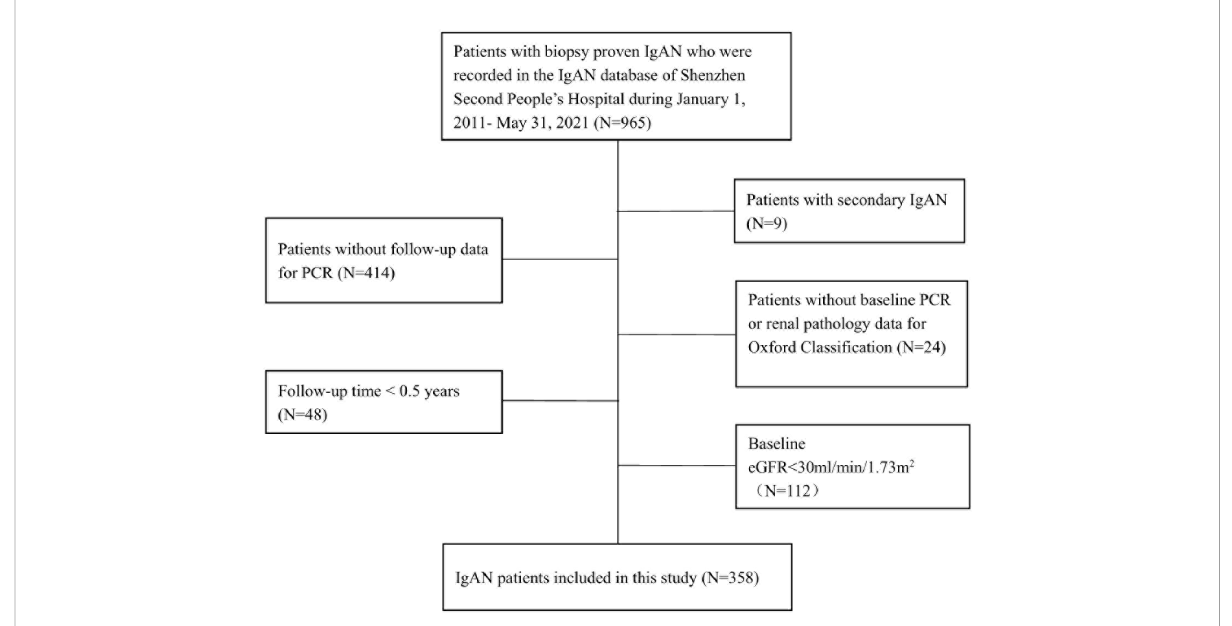
FIGURE 1 Flowchart of patients with immunoglobulin A nephropathy included in the